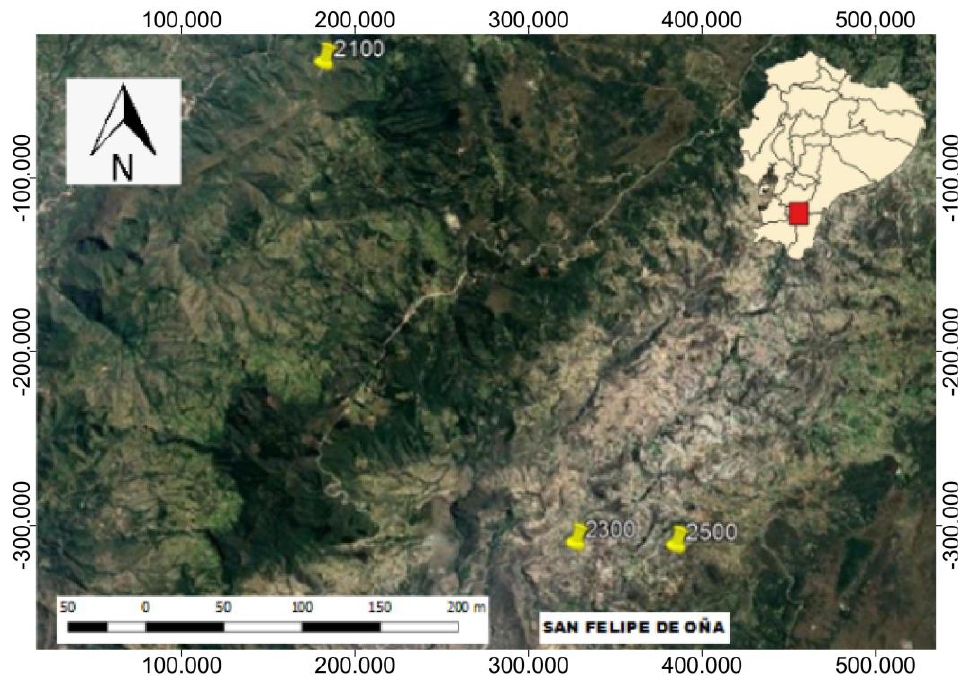
Figure 1. Study area (Cantón Oña-Azuay province) with the three elevations in the montane shrub- lands of southern Ecuador.